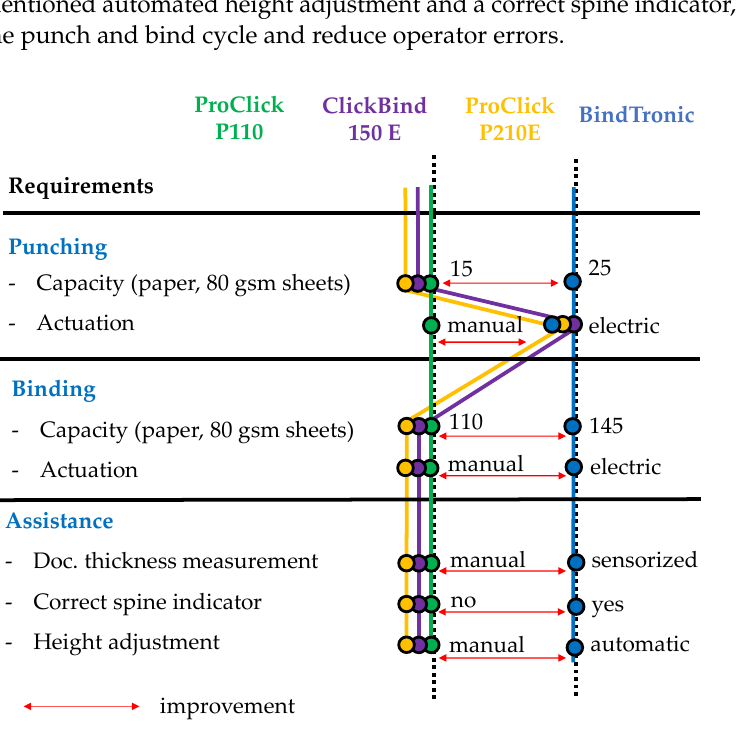
Figure 3. Different ProClick binding profiles and BindTronic improvements.